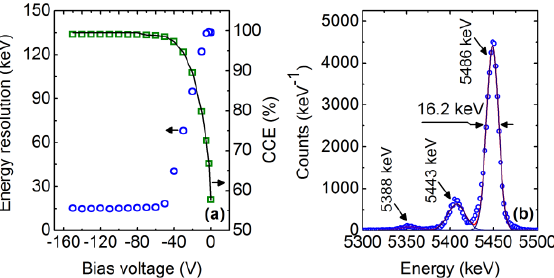
Fig. 3. (a) Variation of energy resolution (blue circles, left axis) and CCE (green squares, right axis) with reverse bias. The solid line shows the fitting of Eq. 2 to the measured CCE values. (b) Pulse height spectrum obtained using a Ni/20  m-4H-SiC SBD exposed to a 241 Am alpha source. The solid lines are the Gaussian